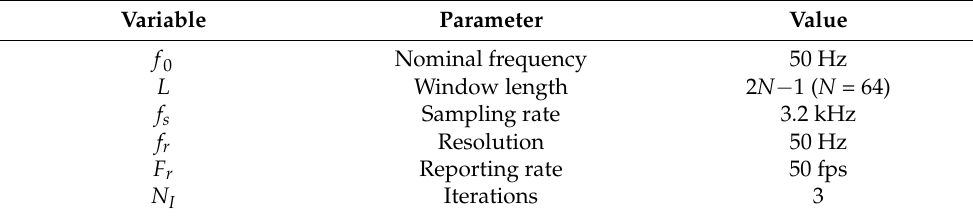
Table 1. Algorithm Table 1. Algorithm parameters.